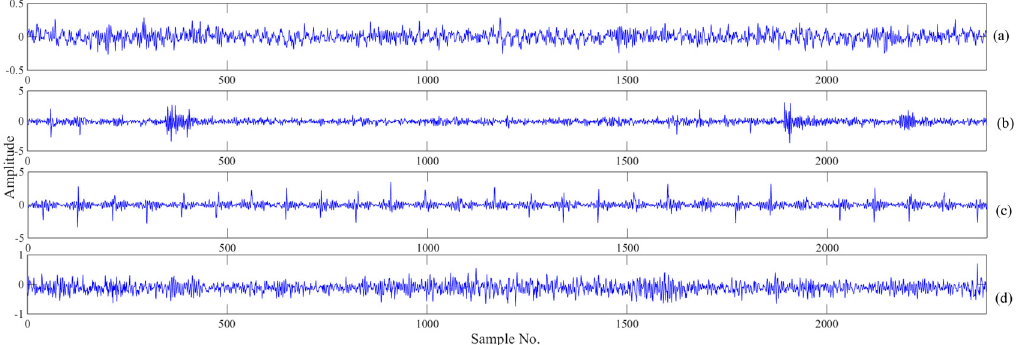
Figure 8. Vibration signals of each bearing condition. ( a ) normal, ( b ) inner race fault (IRF), ( c ) outer race fault (ORF), ( d ) roller defect (RD).